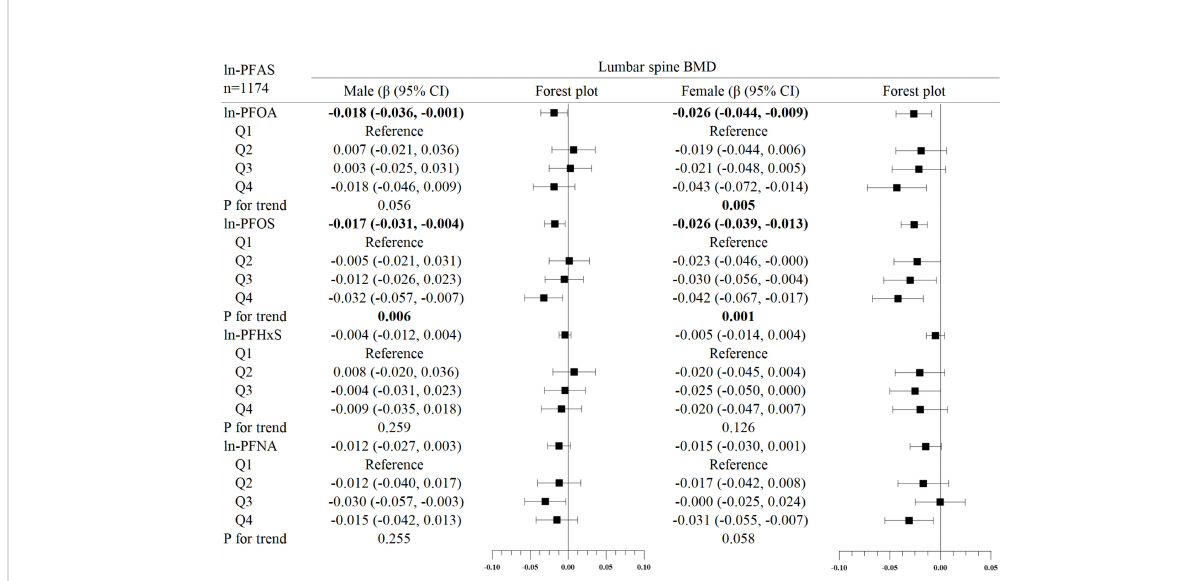
FIGURE 4 Association between ln-PFHxS and bone mineral density, strati fi ed by gender. Adjusted for age, race, income poverty ratio, serum cotinine, vigorous physical activity, moderate physical activity, BMI, serum lead, albuminuria, and anemia. The bold values indicate signi fi cance (p<0.05).